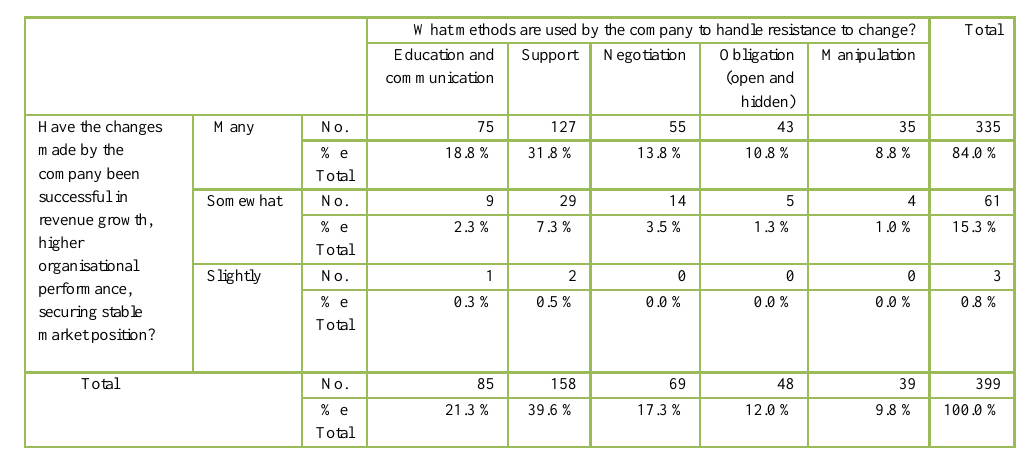
Table 3. Methods for the Treatment of Resistance to Change (developed by the